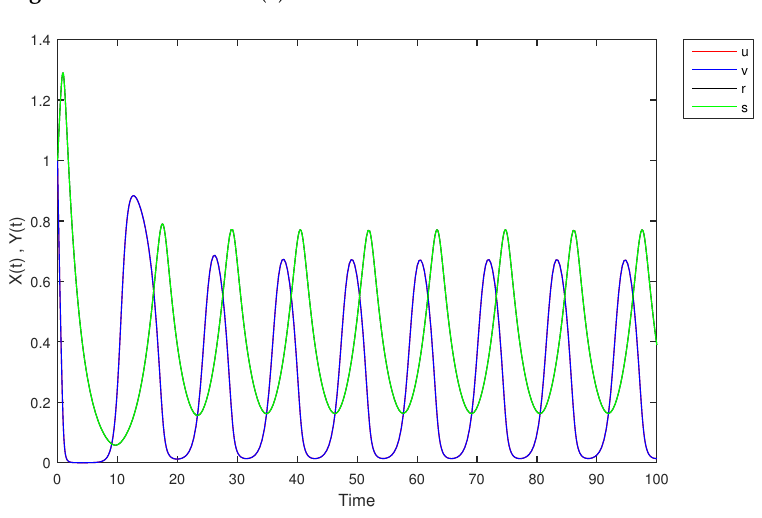
Figure 5. The solution of (5) at α = 0.5.